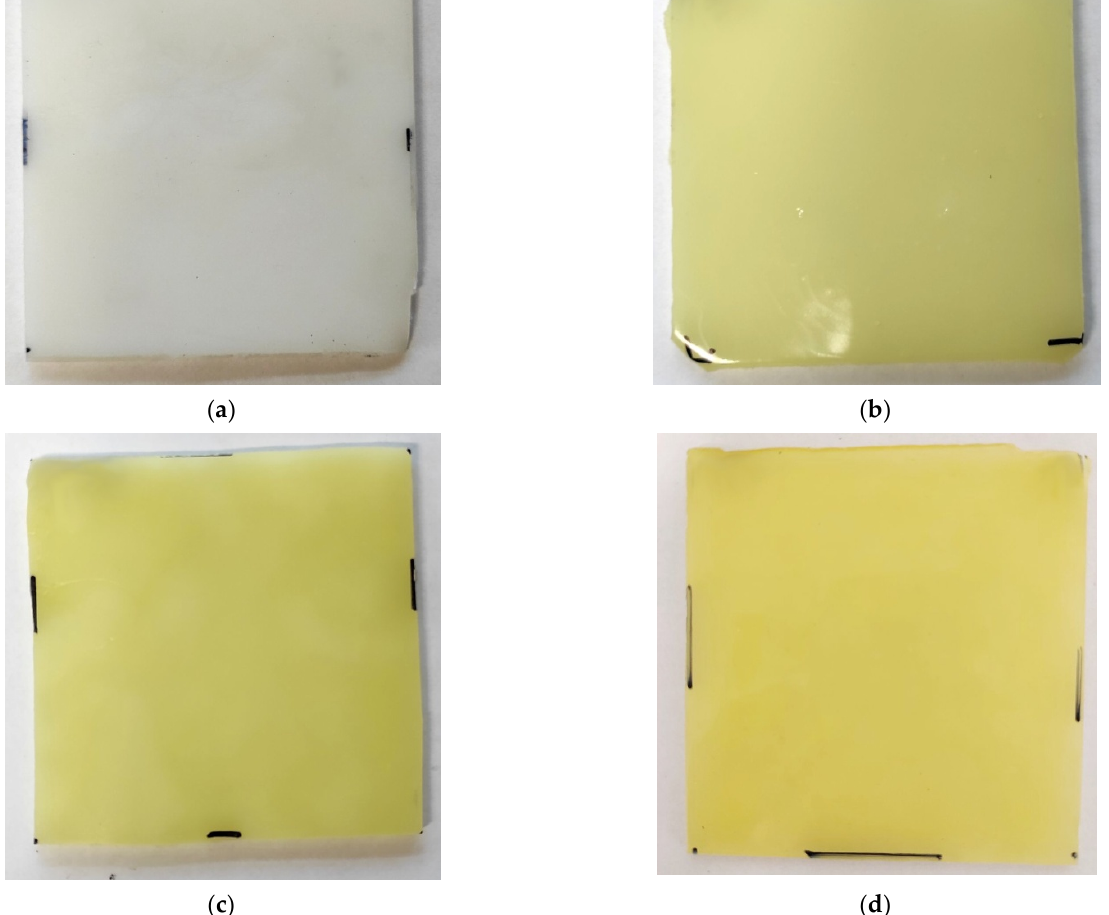
Figure 7. Polyurethanes before cone calorimeter tests: ( a ) REF, ( b ) FPU-8.5, ( c ) FPU-9.0, ( d ) FPU-9.5. Flame spread rate can be calculated based on the pHRR and TTI values [31].